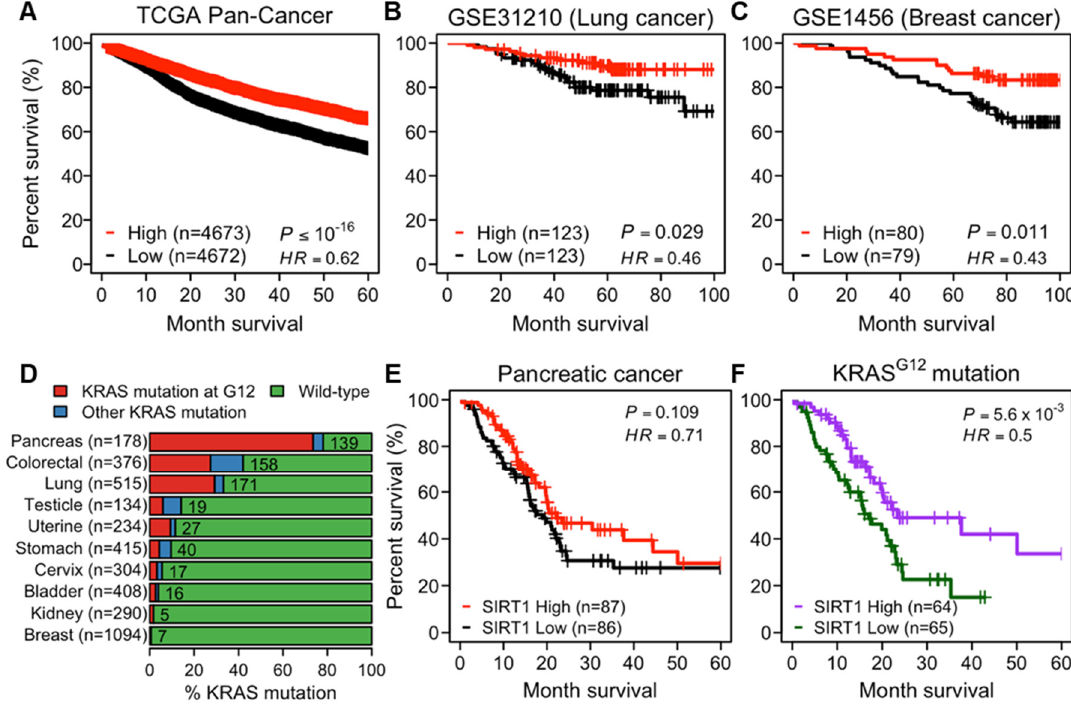
Figure 1. Protective role of SIRT1 in human cancer. (A–C) The Kaplan–Meier curves showing overall survival (OS) of cancer patients stratified by SIRT1-high and -low groups. Patients were divided into SIRT1-high and -low expression groups, using the median SIRT1 expression as a cutoff. OS stratified by SIRT1-high and -low groups in patients in The Cancer Genome Atlas (TCGA) pan-cancer cohort (A), lung (B) and breast (C) cancers in the Gene Expression Omnibus (GEO) datasets. (D) A bar graph showing the prevalence of Kirsten rat sarcoma viral oncogene homolog (KRAS) alterations across TCGA tumor samples grouped by tumor types. The information on KRAS alterations was obtained from cBioPortal. For visualization, ten cancer types including at least five patients with KRAS mutation at glycine 12 (G12) were shown. The number of patients with KRAS mutations is indicated on the bar graph. (E, F) The Kaplan–Meier curves showing OS stratified by SIRT1-high and -low groups in TCGA pancreatic cancer patients (E) and those carrying KRAS G12 (F).